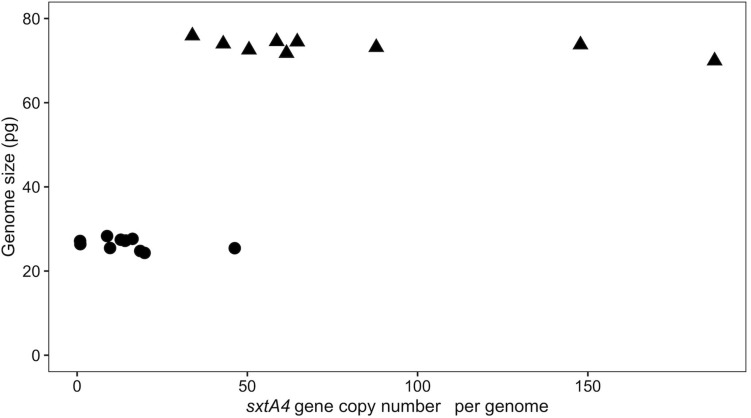
Scatterplots of the correlation between genome size and the sxtA4 CPN (ρ = 0.58, S = 564, p = 0.009) for the A. minutum (circles) and A. pacificum (triangles) strains.